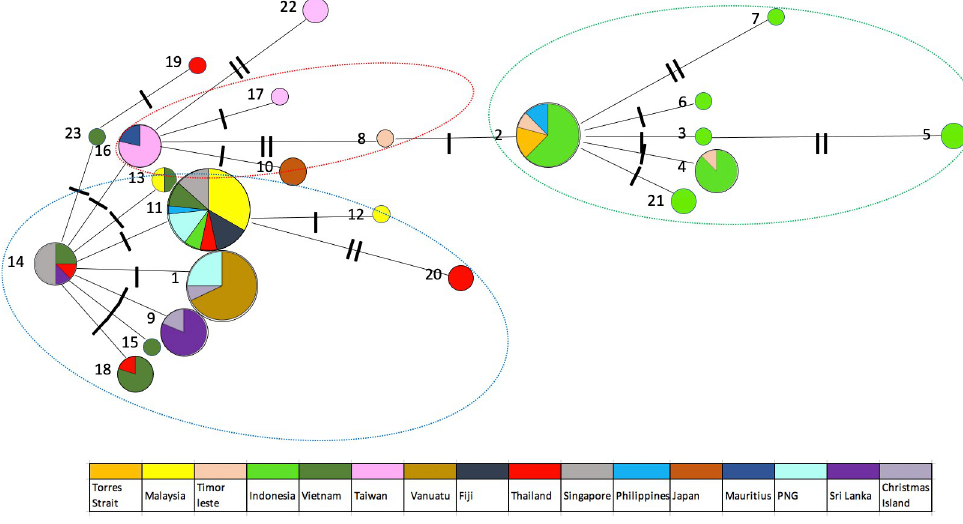
Fig 2. Haplotype network for COI. Each coloured node represents an observed haplotype with circle size indicating the number of individuals with each numbered haplotype and the slash along the connecting lines indicating the number of nucleotide